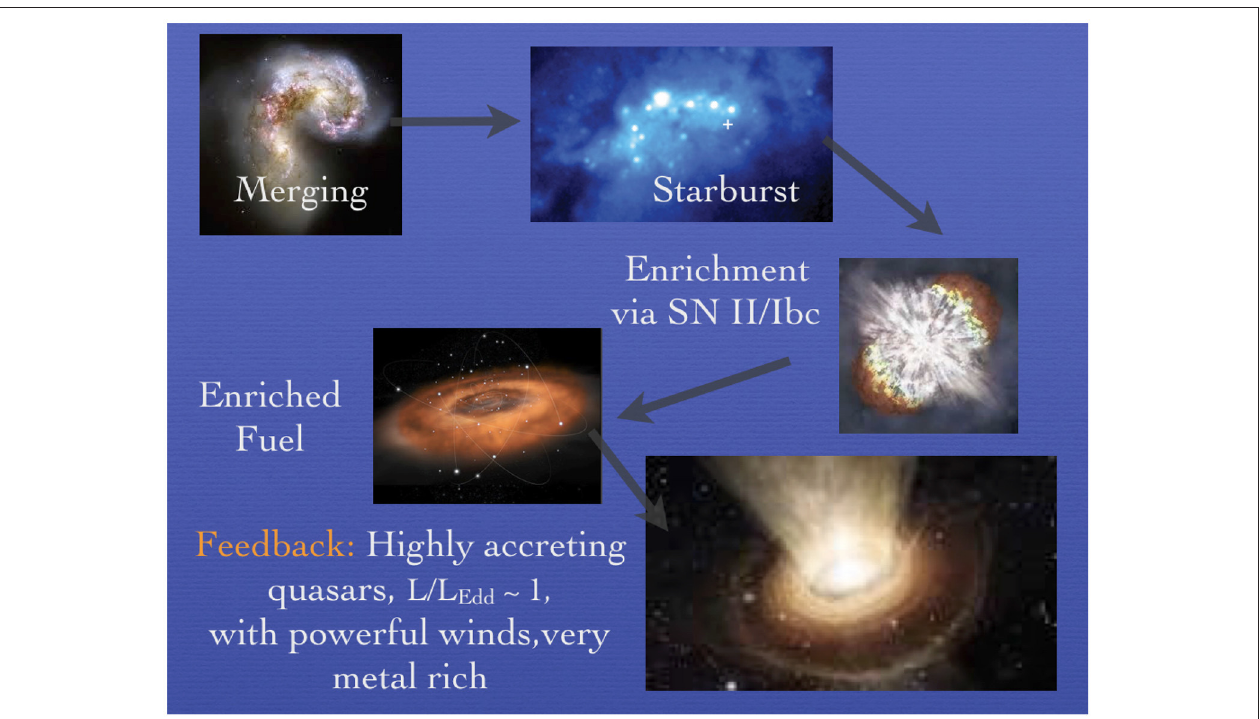
FIGURE 7 | The early stages in the evolution of AGN and quasars: merging and strong interaction lead to accumulation of gas in the galaxy central regions, inducing a burst of star formation (Top) . Mass loss due to stellar winds and supernova explosions eventually provides accretion fuel for the massive black hole at the galaxy center. Radiation force and mechanical energy can then sweep the dust surrounding the black hole, at least within a cone coaxial with the accretion disk axis from where the radiative and mechanical output is free to escape into the host galaxy ISM (Bottom)